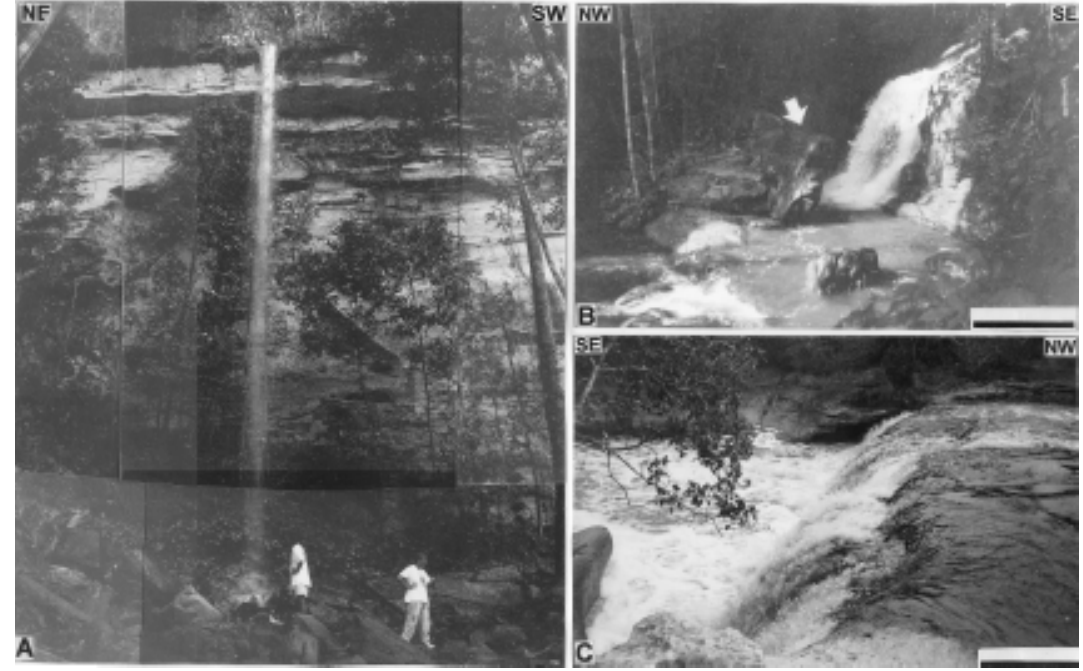
Fig. 3 – General aspects of fault scarps. A) Paredão Waterfall. B) Onça Waterfall, showing a rock slice detached from the fault plain (arrow). C) Fall preceeding the Iracema Waterfall. Scale bar is 3m.